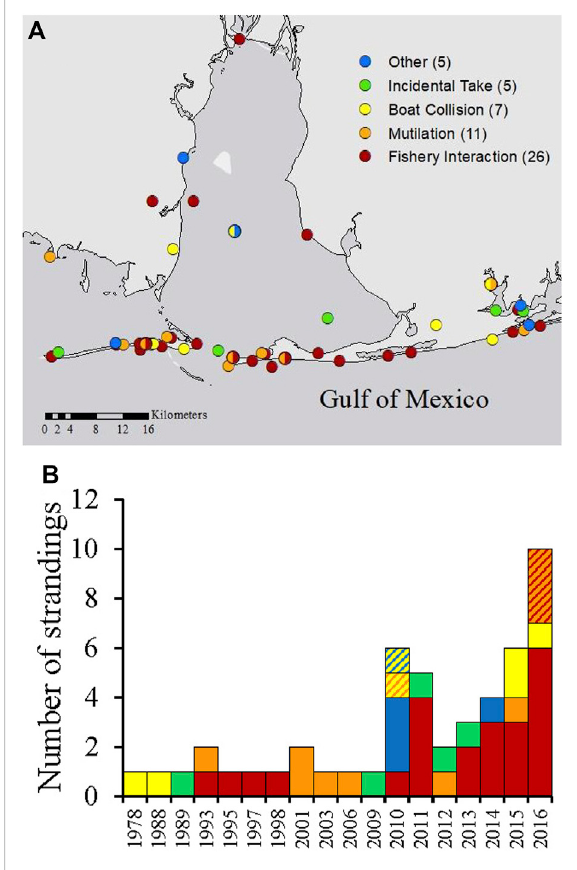
FIGURE 5 Location (A) and total annual numbers (B) of HI-positive strandings in Alabama, separated by HI type. Strandings that included more than one type of HI ( n = 5) are indicated by multicolored circles (A) and muticolored hashed bars (B)